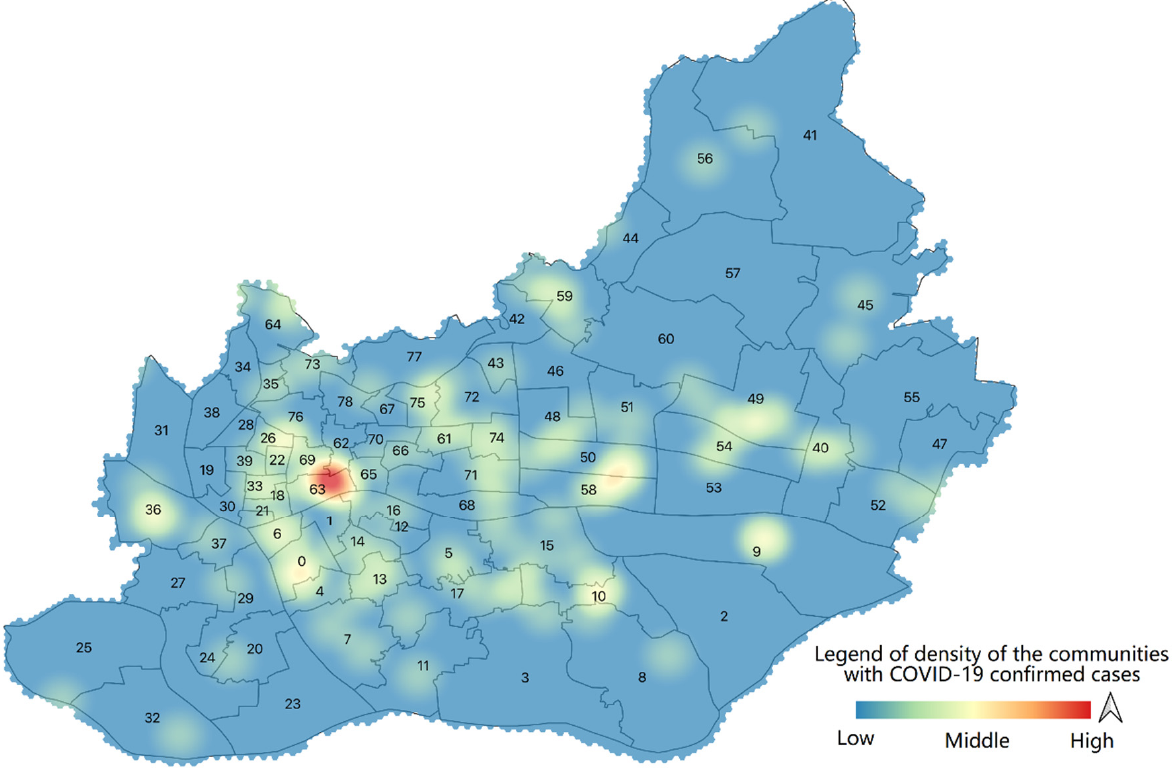
Figure 9. Interpolated density map of confirmed cases of coronavirus disease 2019 (COVID-19).